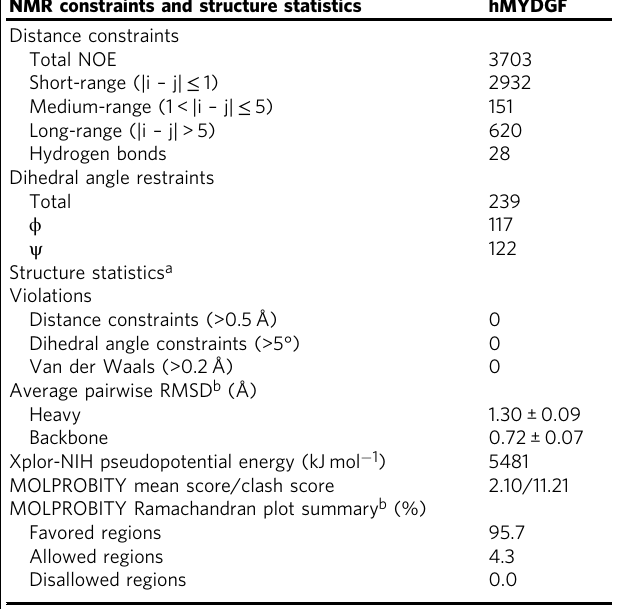
Table 1 NMR and re fi nement statistics for the solution structure of